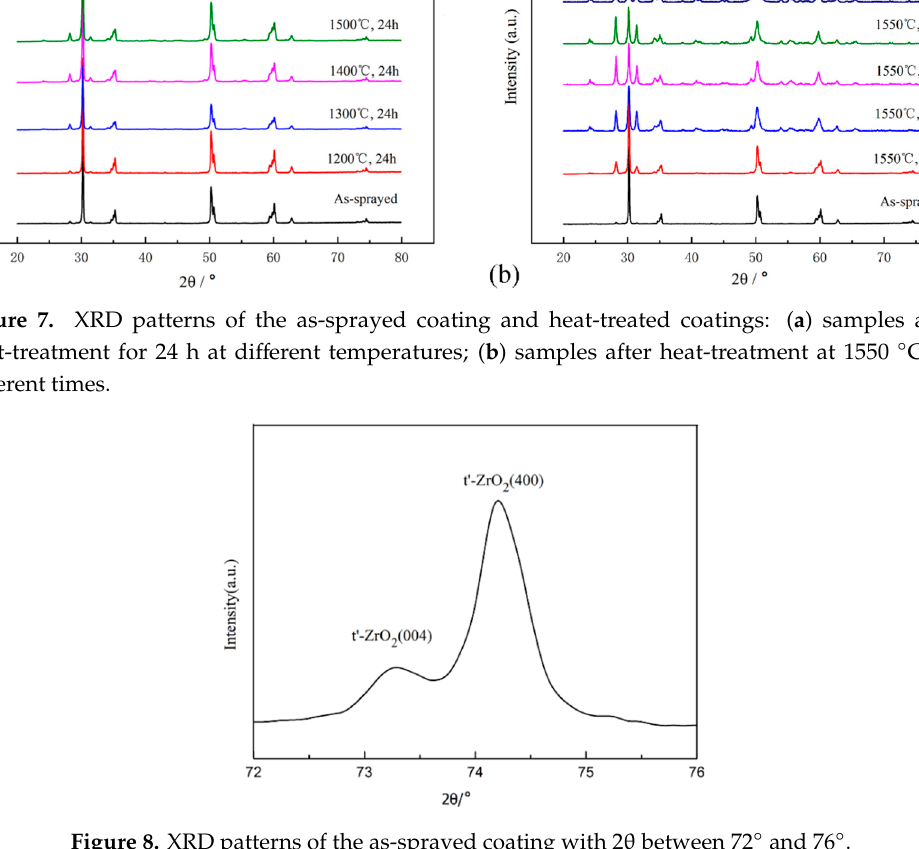
Figure 9. Raman spectra of the as-sprayed coating and heat-treated coatings: ( a ) samples after heat- treatment for 24 h at different temperatures; ( b ) samples after heat-treatment at 1550 °C for different times. 3.3. Mechanical Properties After high-temperature heat treatment, the microstructure, including grain size, cracks and pores, of the YSZ coatings changed significantly, and the mechanical properties of the YSZ coatings also changed accordingly. Hardness ( H ) and Young’s Modulus ( E ) are very important mechanical